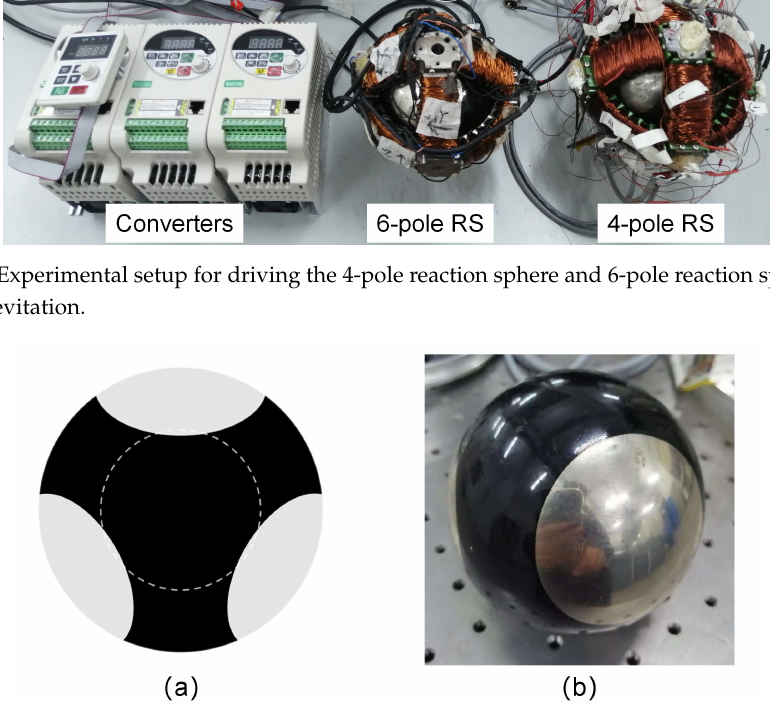
Figure 12. Spherical rotor with black painting for speed counts: ( a ) diagram and ( b ) prototype. Table 5. Maximum speed of the four-pole reaction sphere prototype and the six-pole reaction sphere prototype. Four-Pole Reaction Axis